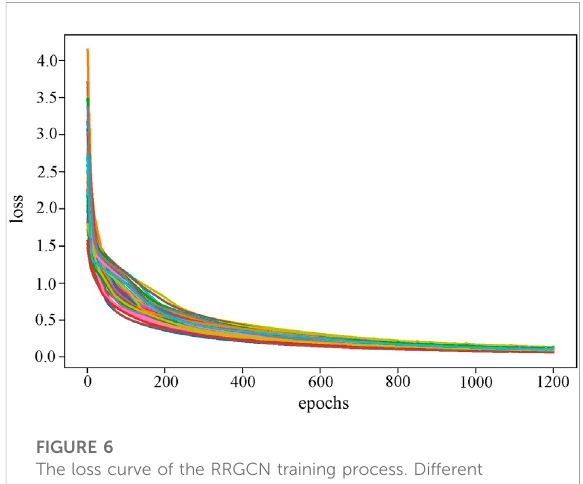
FIGURE 6 The loss curve of the RRGCN training process. Different colors re fl ect the loss curves of different cross-validation times.